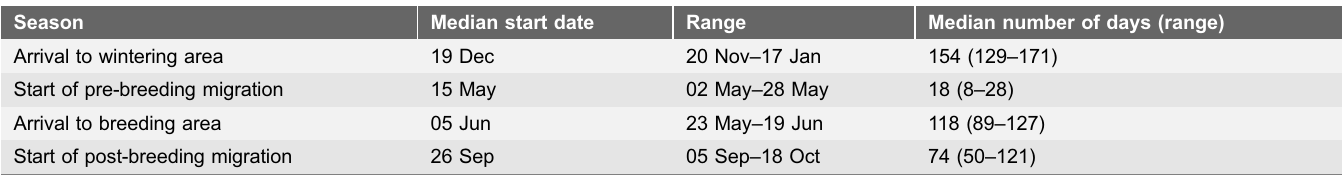
Table 1. Range of start dates, median start date and the median number of days and range for each season of the annual cycle for the 12 satellite-tagged ivory gulls throughout the study period, July 2010- July 2013.